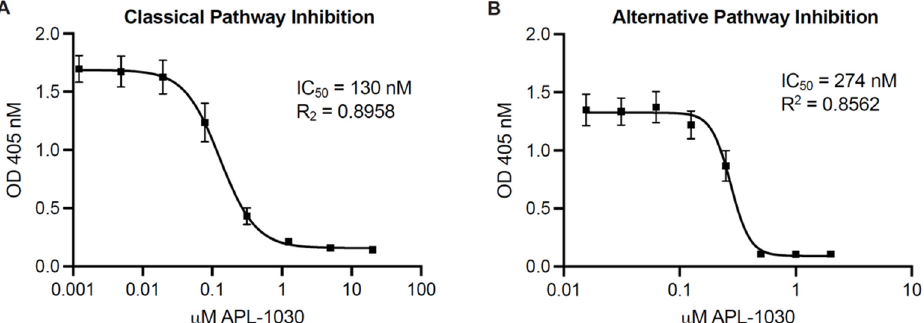
Figure 5. APL-1030 inhibits classical and alternative complement pathway activation. In vitro complement inhibition was assessed by the Wieslab assay for classical pathway activation ( A ) and alternative pathway activation ( B ). IC 50 , half-maximal inhibitory concentration; OD, optical density. Plots represent three independent experiments using 3threedifferent sources of serum from healthy human donors; error bars represent the SEM; lines represent nonlinear regression analysis.